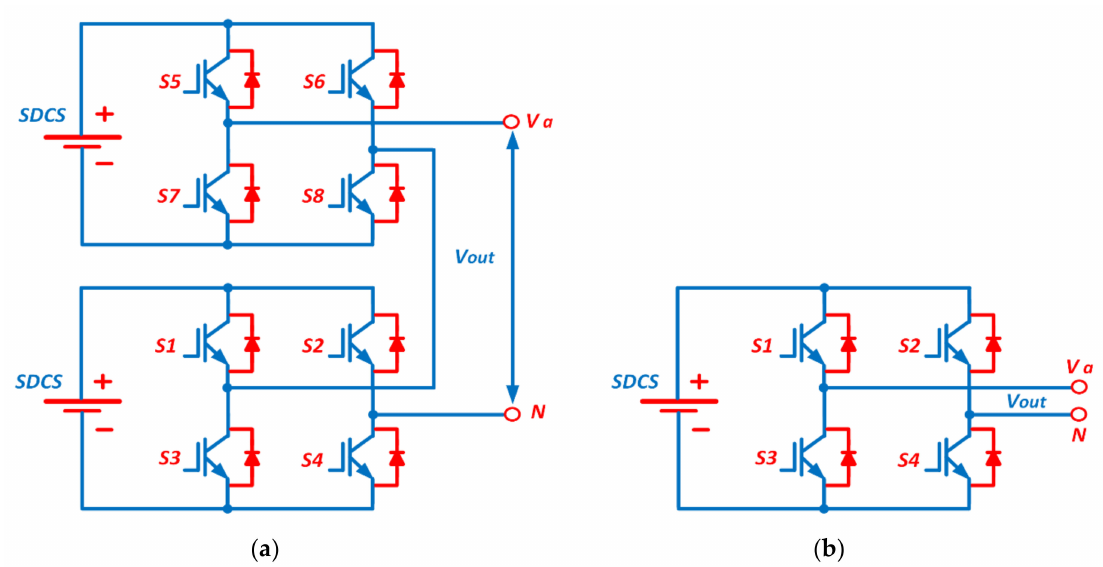
Figure 3. ( a ) Five-level CHBMLI topology, ( b ) three-level CHBMLI